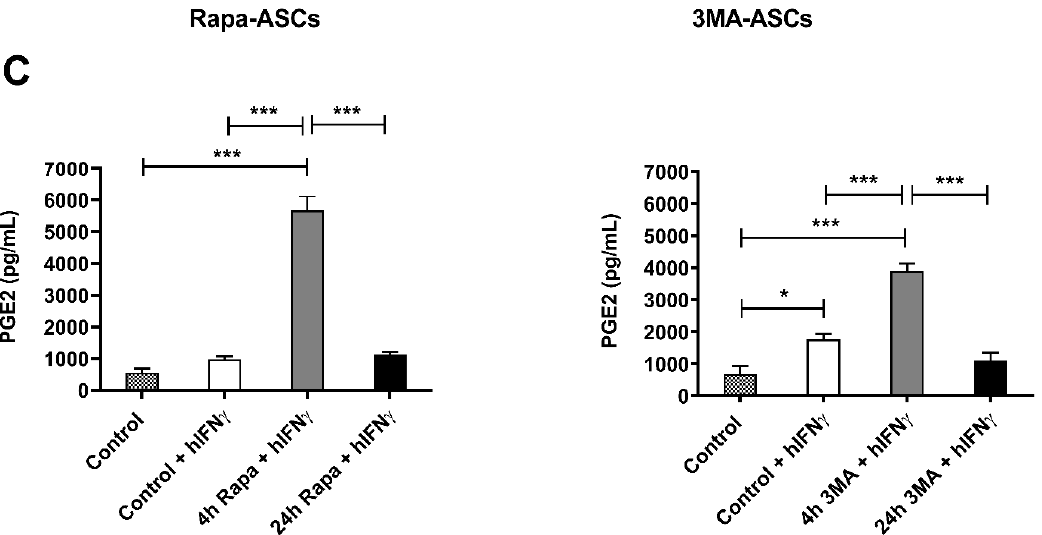
Figure 3. Autophagy preconditioning in hASCs alters their transcriptional and secretory response to pro-inflammatory stimulation with hIFN γ . Rapa-ASCs (left) and 3MA-ASCs (right) were pre- conditioned for 4 or 24 h with their respective autophagy compounds, then stimulated with hIFN γ (5 ng/mL) for 24 h. Following stimulation, anti-inflammatory ( A ) and pro-inflammatory ( B ) genes were measured by using RT-qPCR. Data are presented as means ± SEM of 4 independent exper- iments and normalized to controls that were not treated with hIFN γ . ( C ) Secreted PGE2 levels were measured in 24 h CM from autophagy-preconditioned and hIFN γ -stimulated hASCs. Data are presented as means ± SEM of 3 independent experiments. All statistical significance is determined by using one-way analysis of variance (ANOVA). Statistical differences between the means are indi- cated with * p < 0.05, ** p < 0.01, *** p < 0.001, **** p < 0.0001. Abbreviations: TGF- β ,